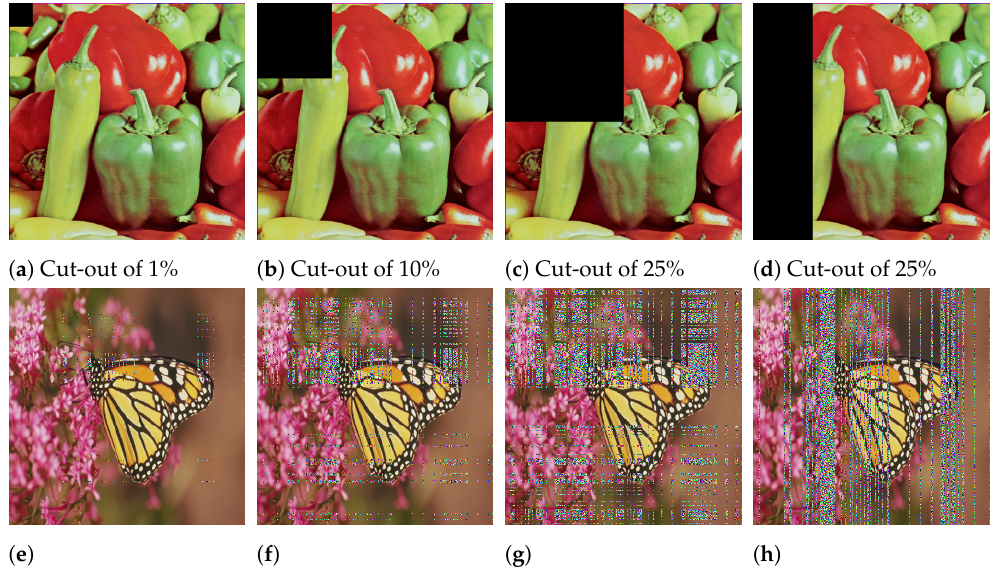
Figure 11. Outcomes of occlusion attacks ( e – h ) with various cut-outs of parts from the encrypted image EImg01-1 ( a – d ).